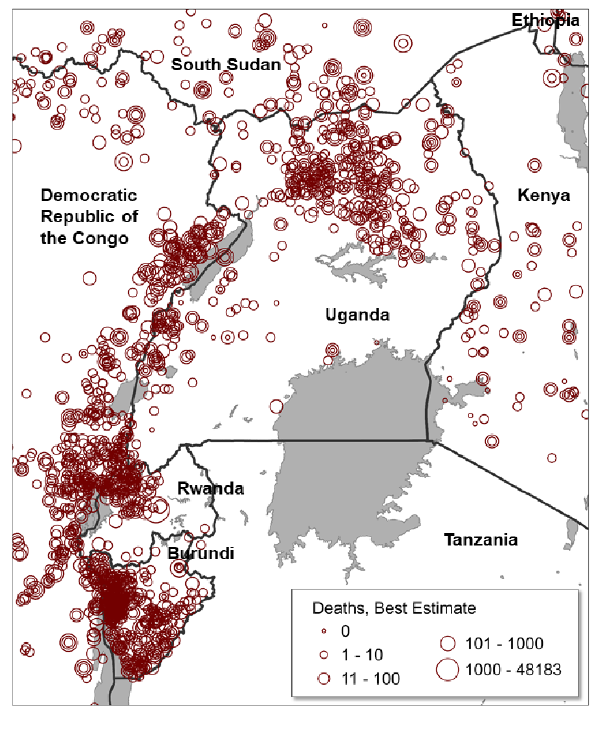
Figure 3 diagrams our proposed framework defining